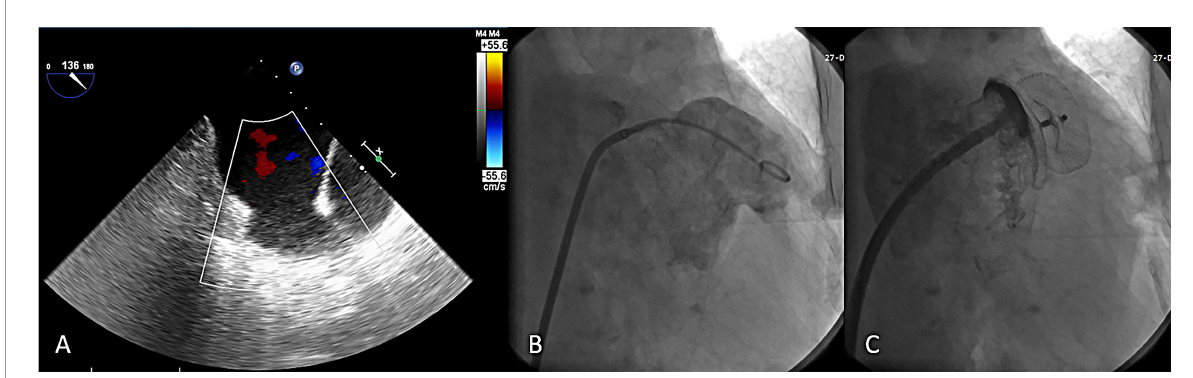
FIGURE2 The largest LACbes device (34 mm) in a shallow left atrial appendage. (A) TEE in 135 ◦ view showed a large and shallow LAA; (B) LAA angiography in a RAO 30 ◦ + caudal 20 ◦ projections showed a “chicken wing” LAA; (C) good sealing after LACbes device implantation under LAA angiography. LAA, left atrial appendage; TEE, transesophageal echocardiography.